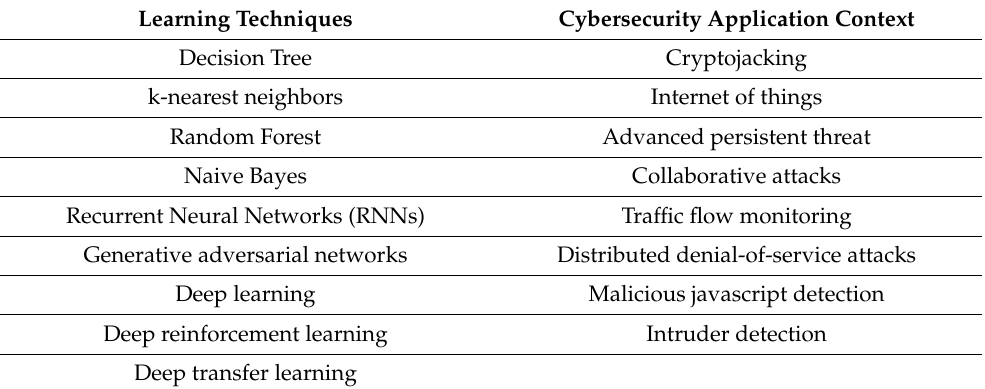
Table 10. Machine learning applied to